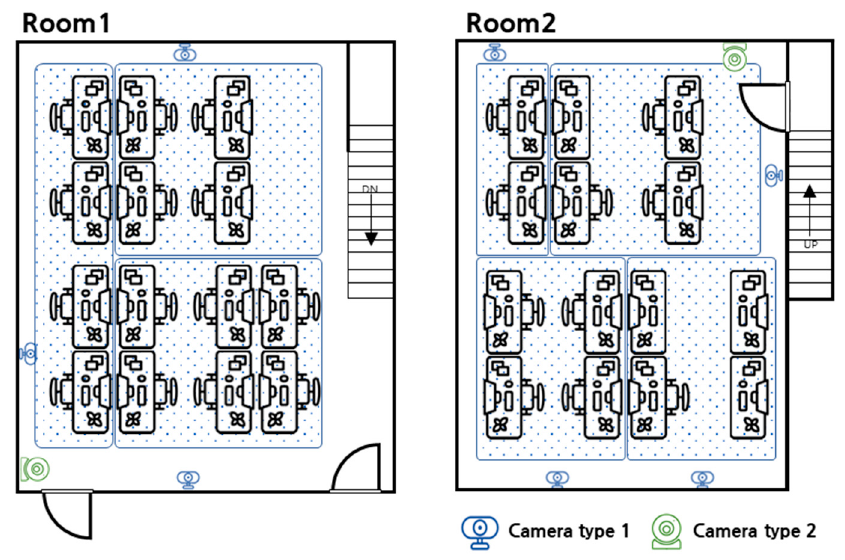
Figure 3. Room structure and camera installation location and area of case